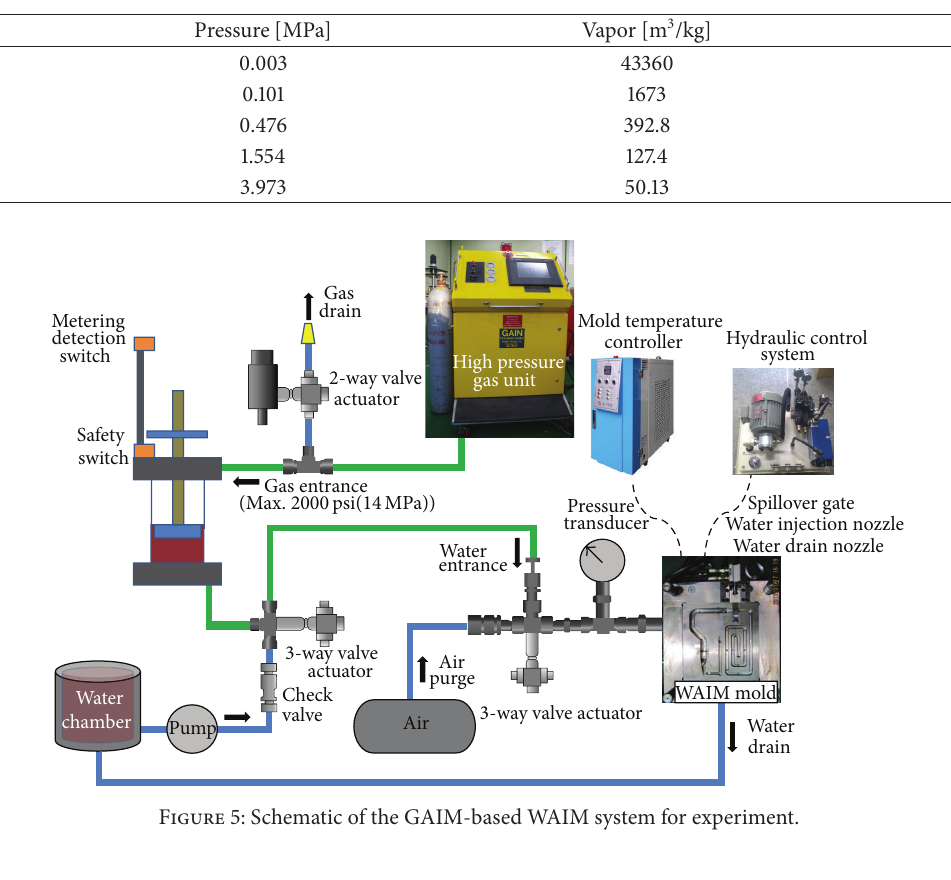
Table 2: Saturated steam values of water.